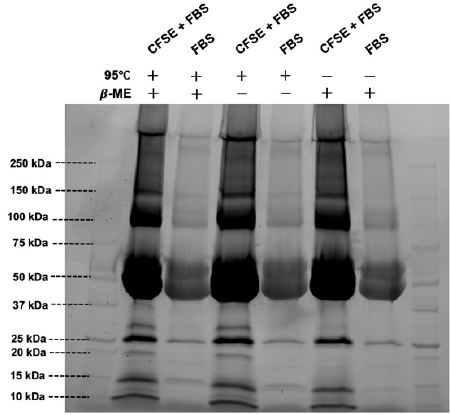
Figure 2. The effect of standard reduction methods upon carboxyfluorescein succinimidyl ester (CFSE)-labeled samples. Standard reduction methods include 95 °C for 10 min and 2-mercaptoethanol used alone and in combination with CFSE-stained and unstained samples on an SDS-PAGE stain-free gel.